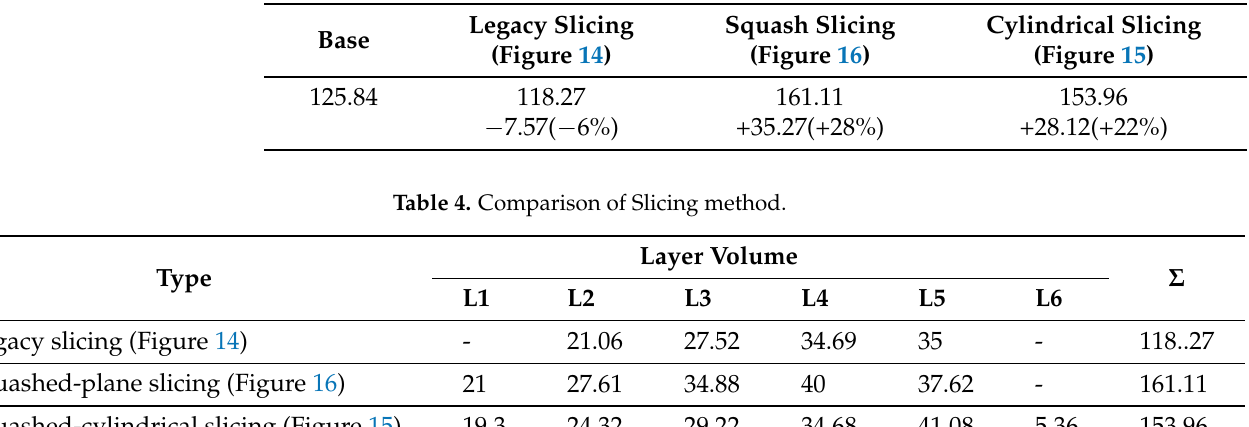
Figure 14. A result of legacy slicing in side view ( a ) and isometric view ( b ). Table 3. Cylindrical slicing and squashing operation volume.